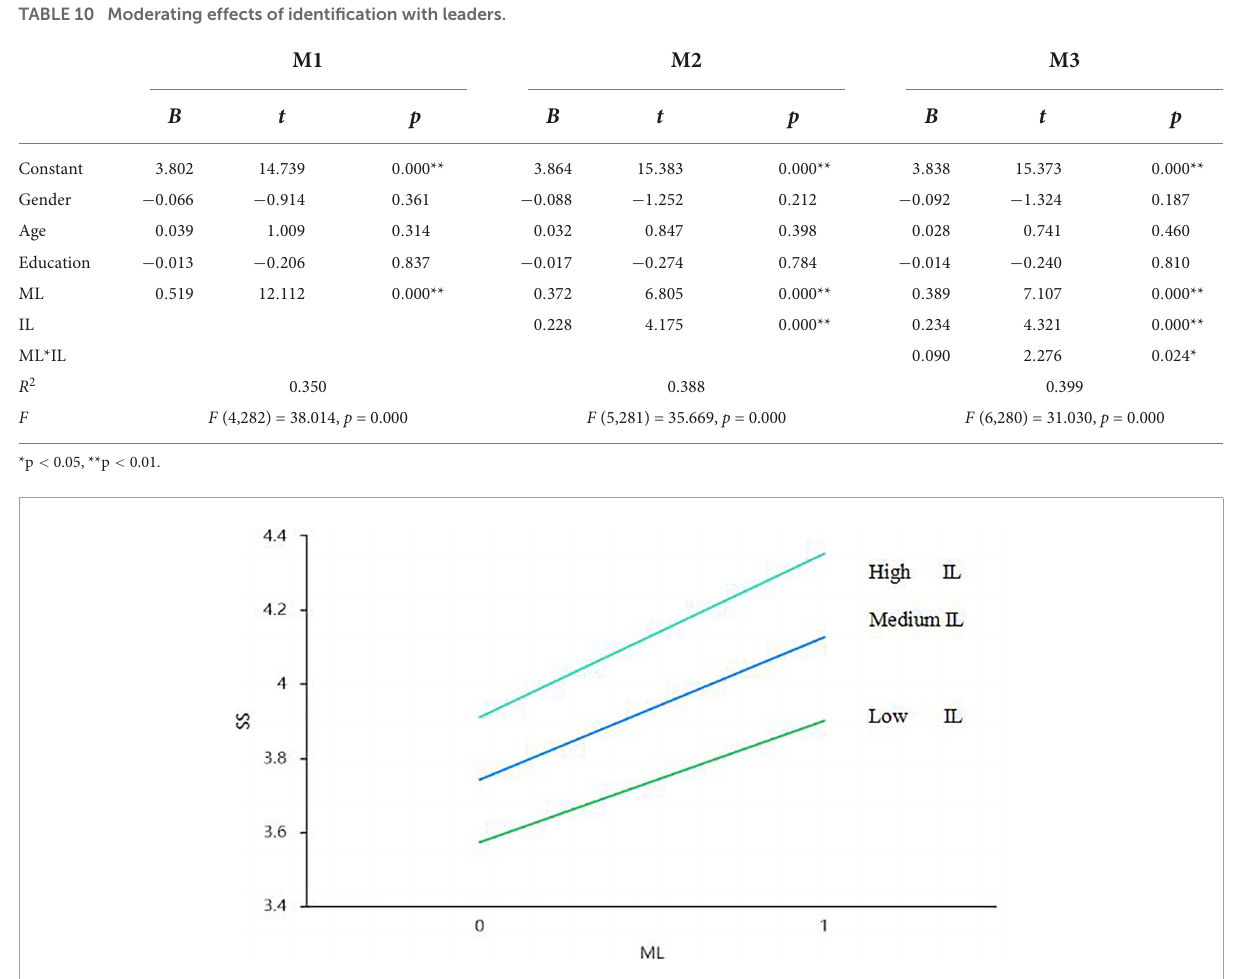
FIGURE2 Moral leadership and psychological safety: the moderating effect of identification with leaders.